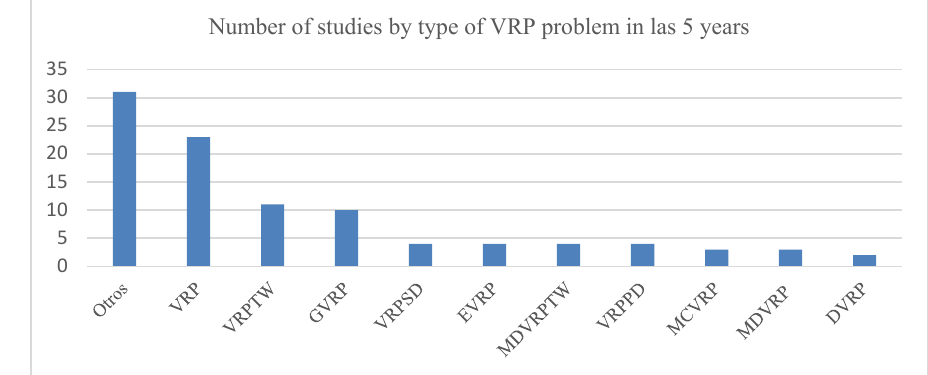
Fig. 1. Number of studies by type of VRP problem in las 5 years. Own